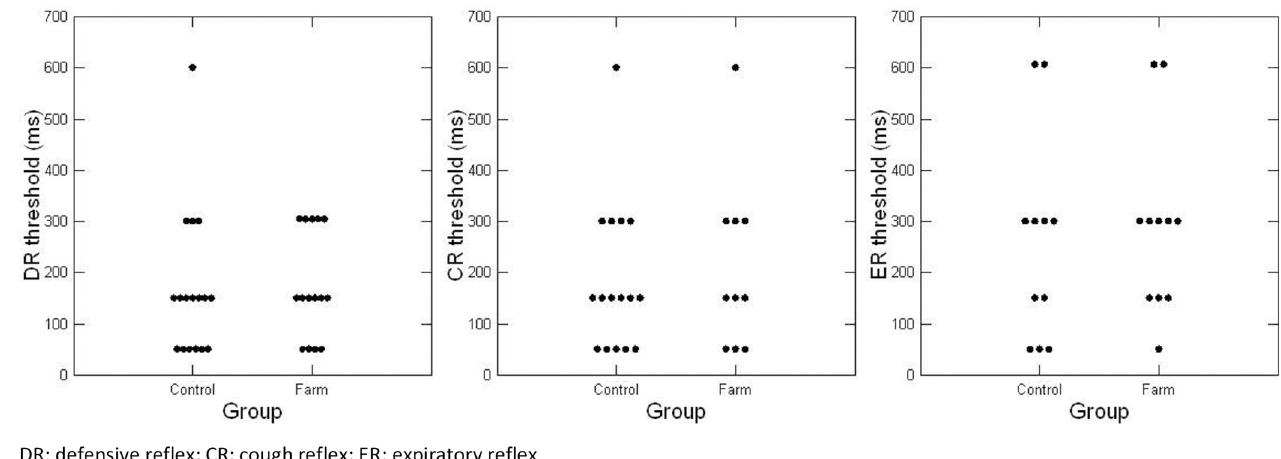
Fig 3. Defensive reflexes threshold (in msec) in the control group and farm group.